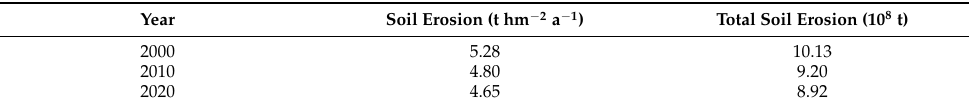
Table 2. Characteristics of different soil erosion intensities from 2000 to 2020.